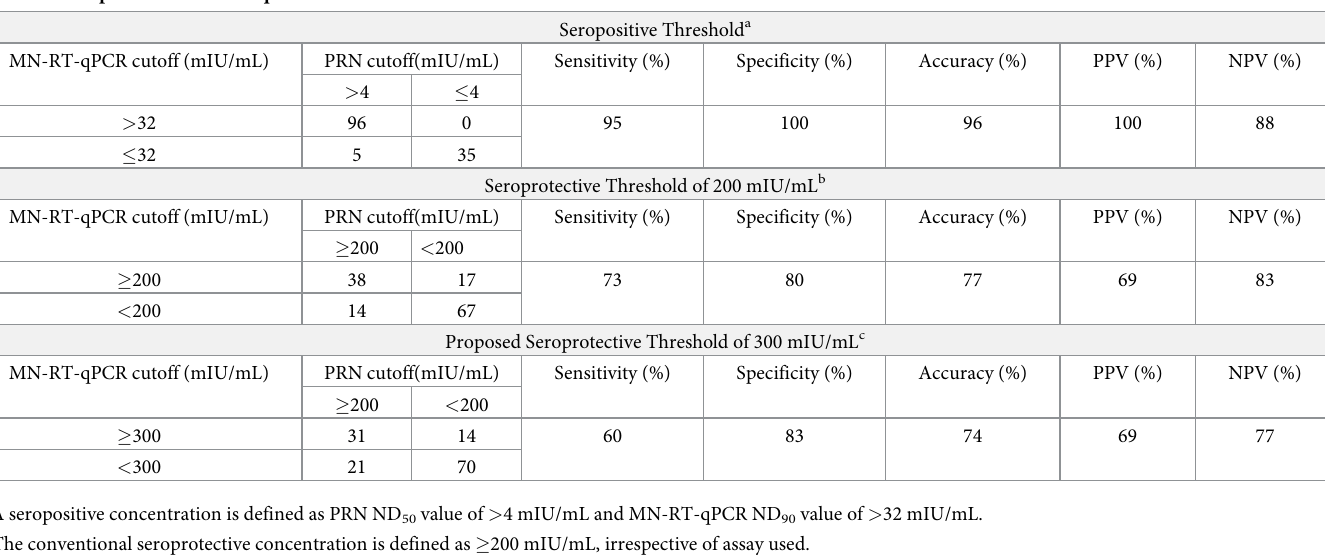
Table 3. Comparison of MN-RT-qPCR and PRN